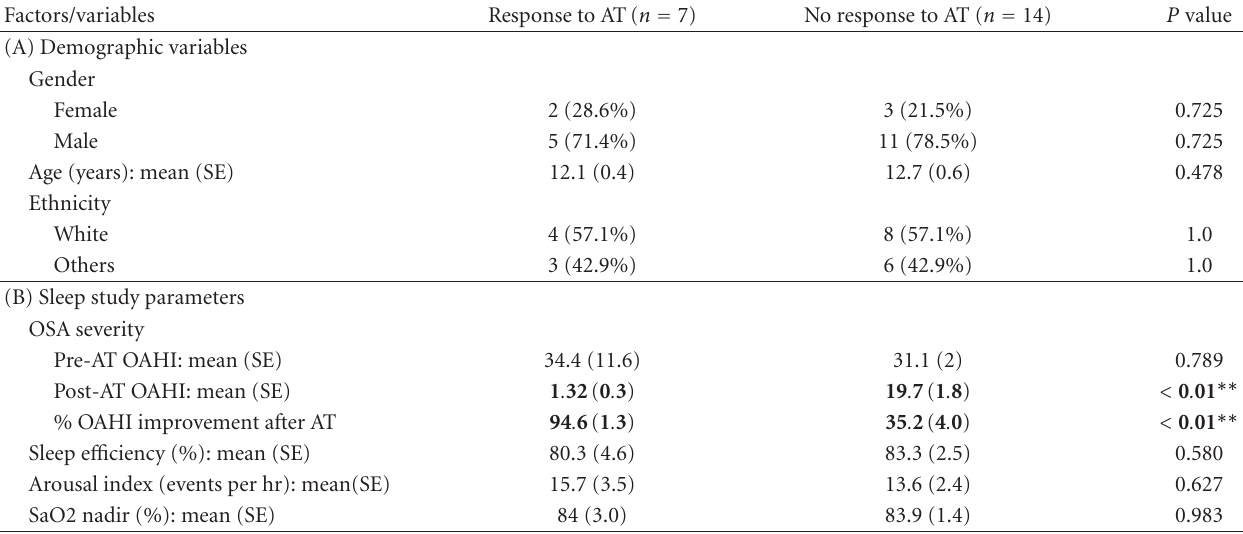
Table 1: Demographic and polysomnographic profile of subjects. For quantitative variables, data are presented as mean ± standard error (SE). AT: adenotonsillectomy; OAHI: obstructive apnea-hypopnea index. For categorical variables, data are presented as count number (column percentage). P values are obtained by either two-sample t -test or chi-square test, depending on the type of variables.